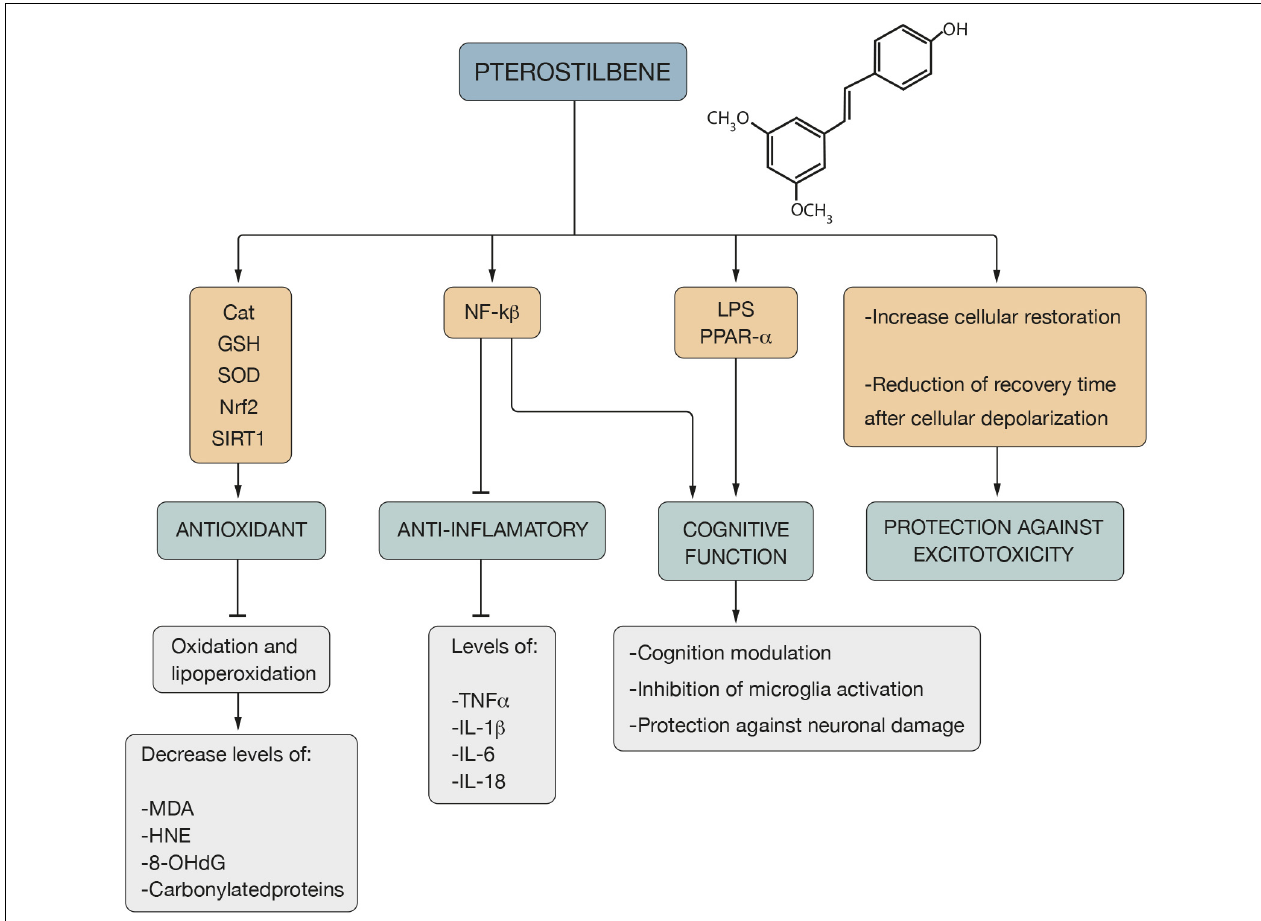
FIGURE 3 | Pterostilbene properties and action mechanism. The antioxidant mechanism of Pter is associated with Cat, GSH, SOD, Nrf2 and SIRT1 pathways, which leads to an inhibition of the oxidation and lipoperoxidation processes, decreasing the levels of MDA, HNE, 8-OHdG and carbonilated proteins. Its action on NF-kß involves an anti-inflammatory effect due to the decrease in the levels of TNF- α and interleukins such as IL-1 β , IL-6 and IL-18. Its role on NF-kß, LPS and PPAR- α mediates the cognitive function of Pter, which is expressed through cognition modulation, inhibition of microglia activation and protection against neuronal damage. In addition, Pter presents protection against excitotoxicity due to the increase in cellular restoration and the reduction of the recovery time after cellular